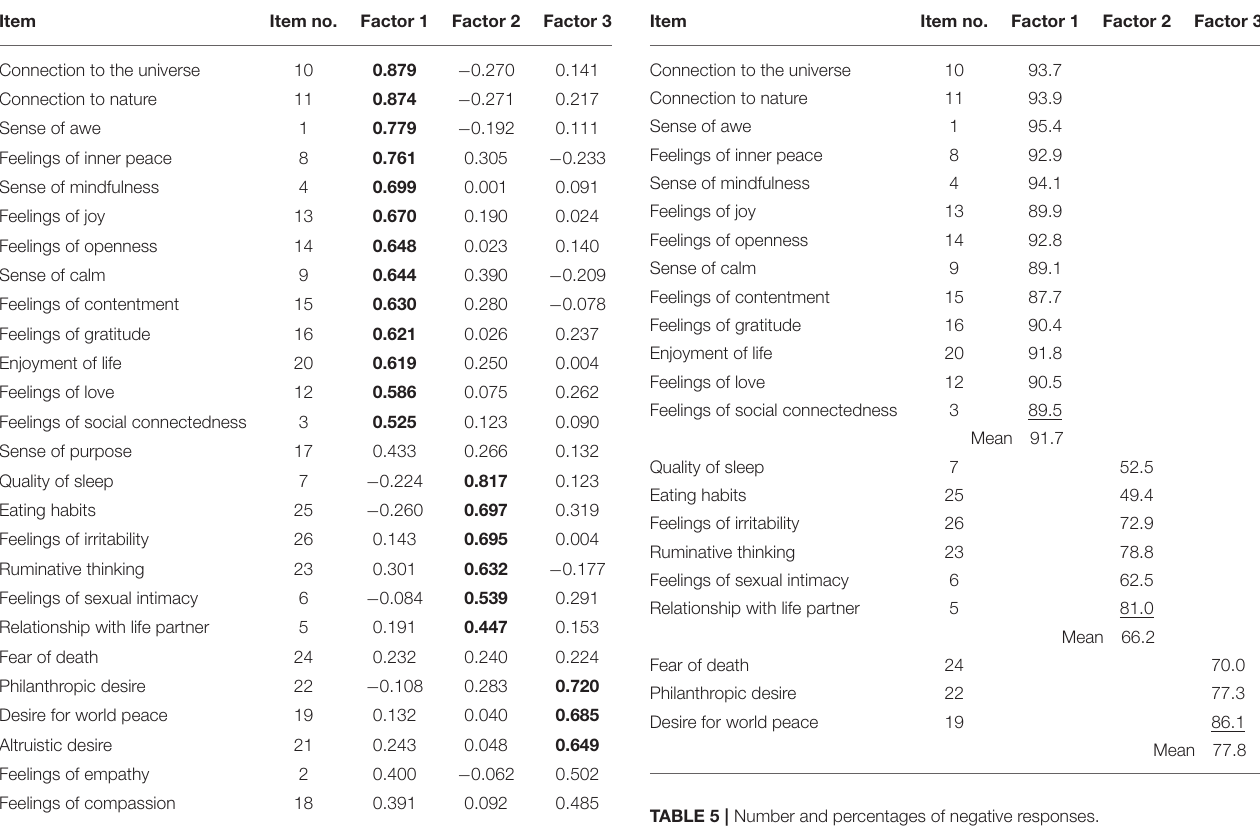
TABLE 3 | Factor loadings for PCQ-26. TABLE 4 | Percentage of respondents indicating improvement on factor items.